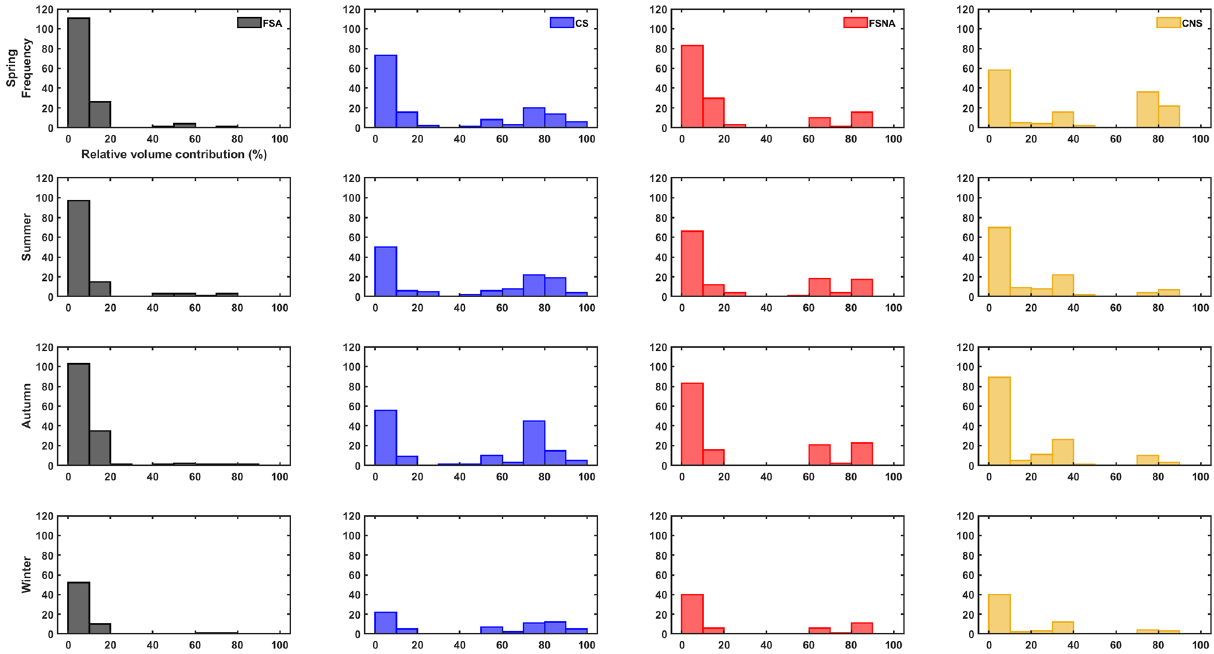
Figure 8. Frequency of occurrence (absolute) of the different aerosol components, in terms of relative volume contribution, during the four seasons. First row: spring months (March, April, and May 2017–2019); second row: summer months (June, July, and August 2017– 2018); third row: autumn months (September, October, and November 2017–2018); and fourth row: winter months (December, January, and February